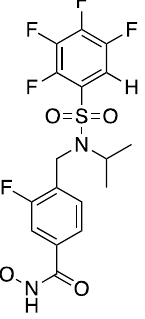
Figure 2. Structure of NN-429. Synthesis of NN-429 available in Supporting Info Scheme S1.